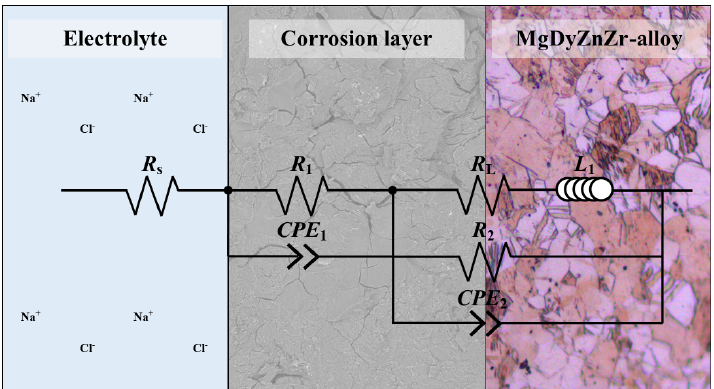
Figure 10. Equivalent electric circuit used to model the experimental impedance data of MgDyZnZr alloy specimens immersed in 0.9 wt.% NaCl solution at 37 ± 0.5 ◦